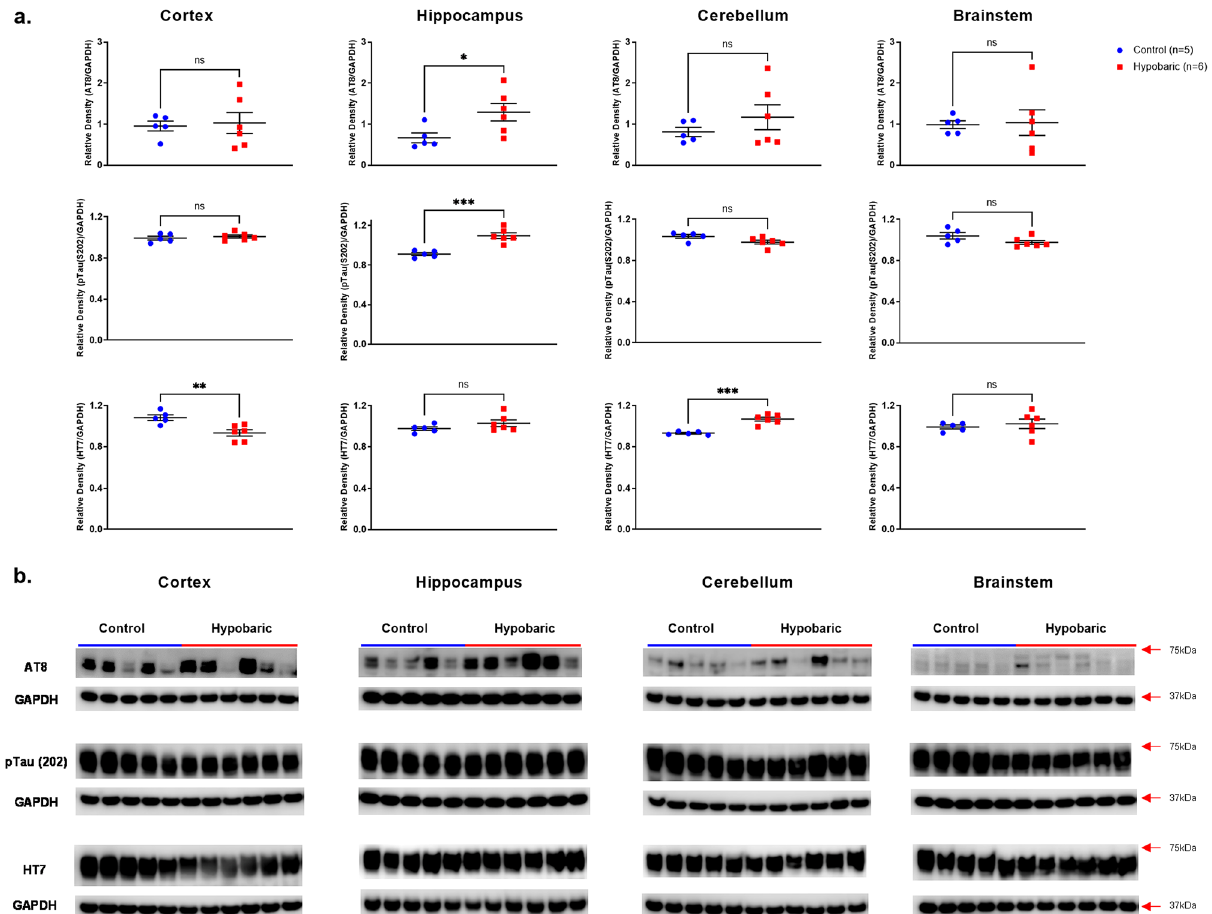
Figure 7. Phosphorylated and Total Tau Protein Expression following Hypobaric Exposure. ( a ) Histograms representing the densitometric ratio of levels of pTau-AT8 (Ser202 and Thr205), pTau (Ser202) and HT7 with respect to GAPDH in the Control (blue spots) vs. HYPOBAR (red squares) group as measured in the frontal cortex, hippocampus, cerebellum and brainstem. All gels were run in duplicate and data represents the average of 2 runs per sample. Error bars represent standard error of the mean (SEM). * p < 0.05; ** p < 0.01 (two-tailed unpaired t -test). ( b ) Representative western blots for antibodies used. Full length blots are shown in Supplementary Figs.